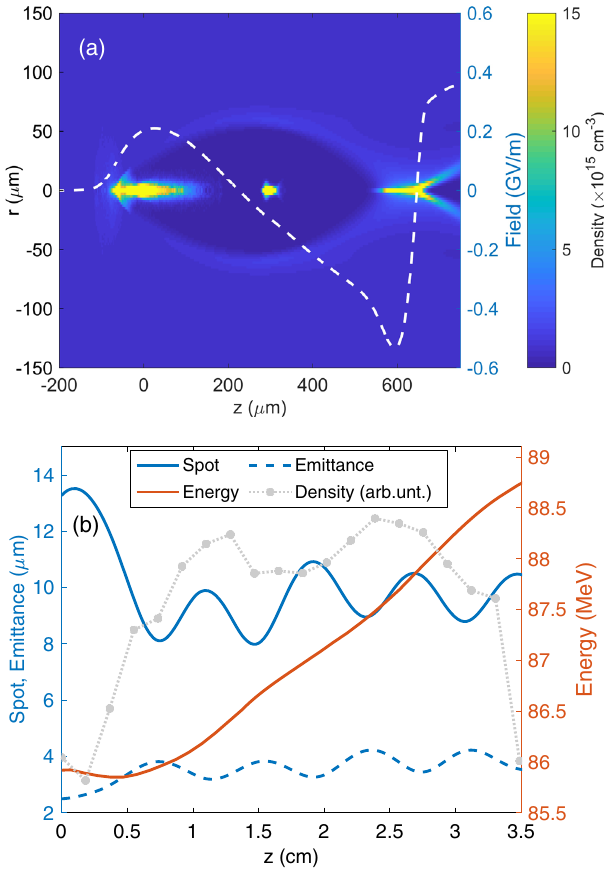
FIG. 5. The evolution of the beam parameters along the plasma section. On image (a) is depicted 2D distribution of the plasma during the acceleration (the beam is traveling from right to left) and the strength of the longitudinal electric field (white dashed line). The evolution of the beam parameters along the plasma is depicted on image